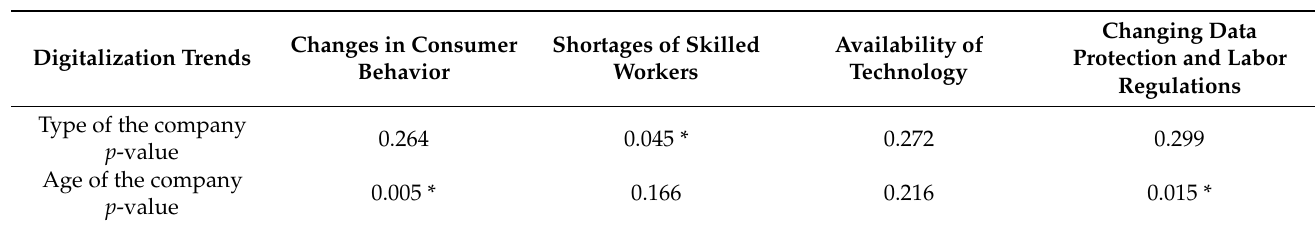
Table 13. Group comparison: digitalization trends vs. type and age of the company— p -value determined by Mood’s median